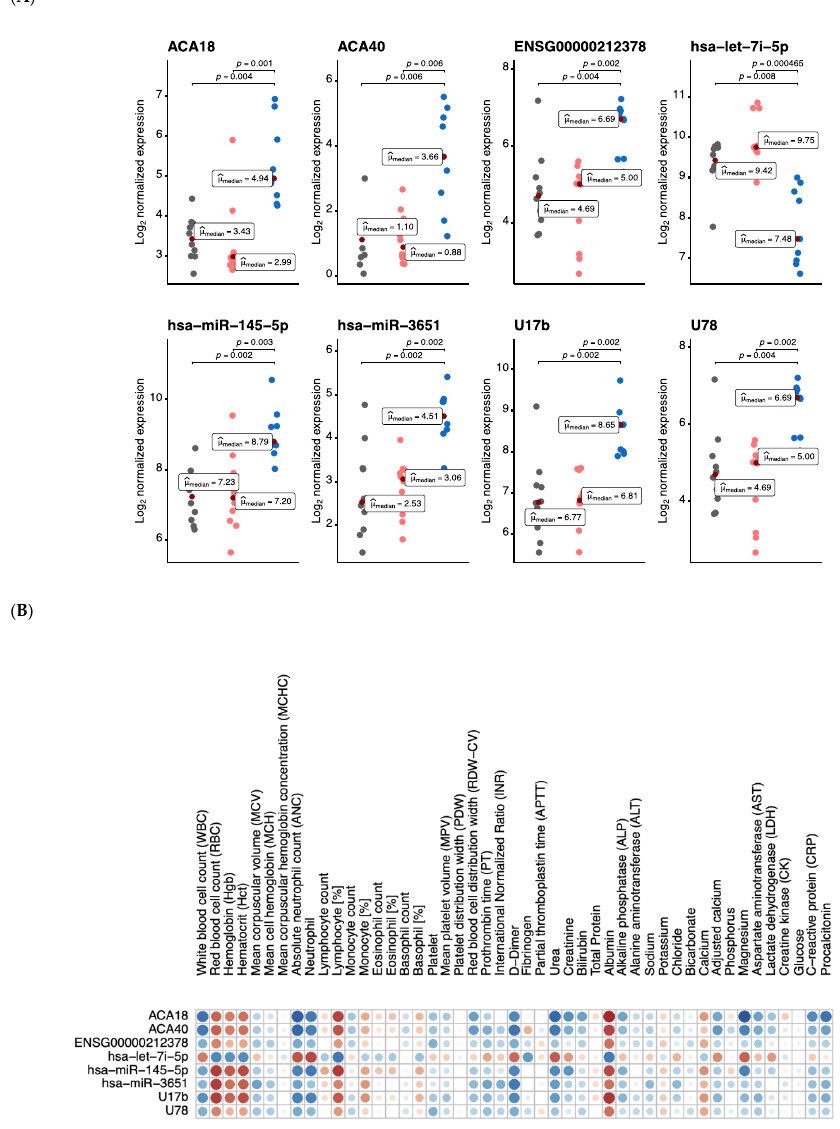
Figure 3. Association of routine clinical markers with differentially expressed common miRNAs and snoRNAs. ( A ) Scatter plots of Log 2 normalized expression values of miRNAs and snoRNAs in asymptomatic (n = 10, grey), mild (n = 10, light orange), and severe (n = 9, blue) cases. The comparison between different severity groups was done using the non-parametric Kruskal–Wallis one-way ANOVA test, the median for asymptomatic, mild, and severe groups is reported as a measure of centrality in each scatter plot. In each respective comparison, the p-adjusted values were calculated using Holm’s sequential Bonferroni procedure for multiple hypothesis tests at an alpha level of 0.05. ( B ) A correlation matrix of the 8 miRNAs and snoRNAs with associated clinical markers. Each cell contains a correlation coefficient between the possible pairs of variables, namely Spearman’s rho statistic calculated at a significance level of 0.05. Color scale ranges from blue (r = − 1) to white (r = 0) to red (r =